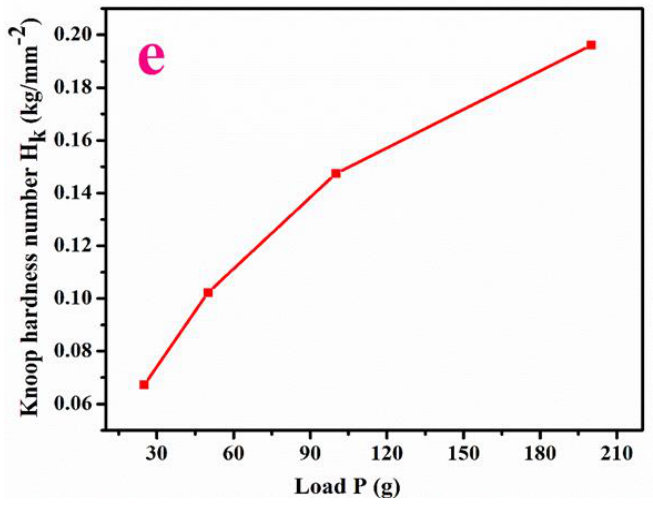
where σ ac represents conductivity and k B signifies the Boltzmann constant. Figure 7d dis- plays the relation of logarithm of ac conductivity with 1000/T which is found to be nearly linear in nature and E a is evaluated using the following expression, E a = −slope * 1000 * k B (22) The E a values are 0.3733, 0.055 and 0.093 eV at the frequency of 30 KHz, 900 KHz and 5 MHz. Its lower value indicates that the LPPMA contains a lower number of defects, which is suitable for device fabrication [23]. Figure 6. ( a – e ) Hardness value, Meyers graph, Yield strength, Stiffness constant, Knoop hardness.